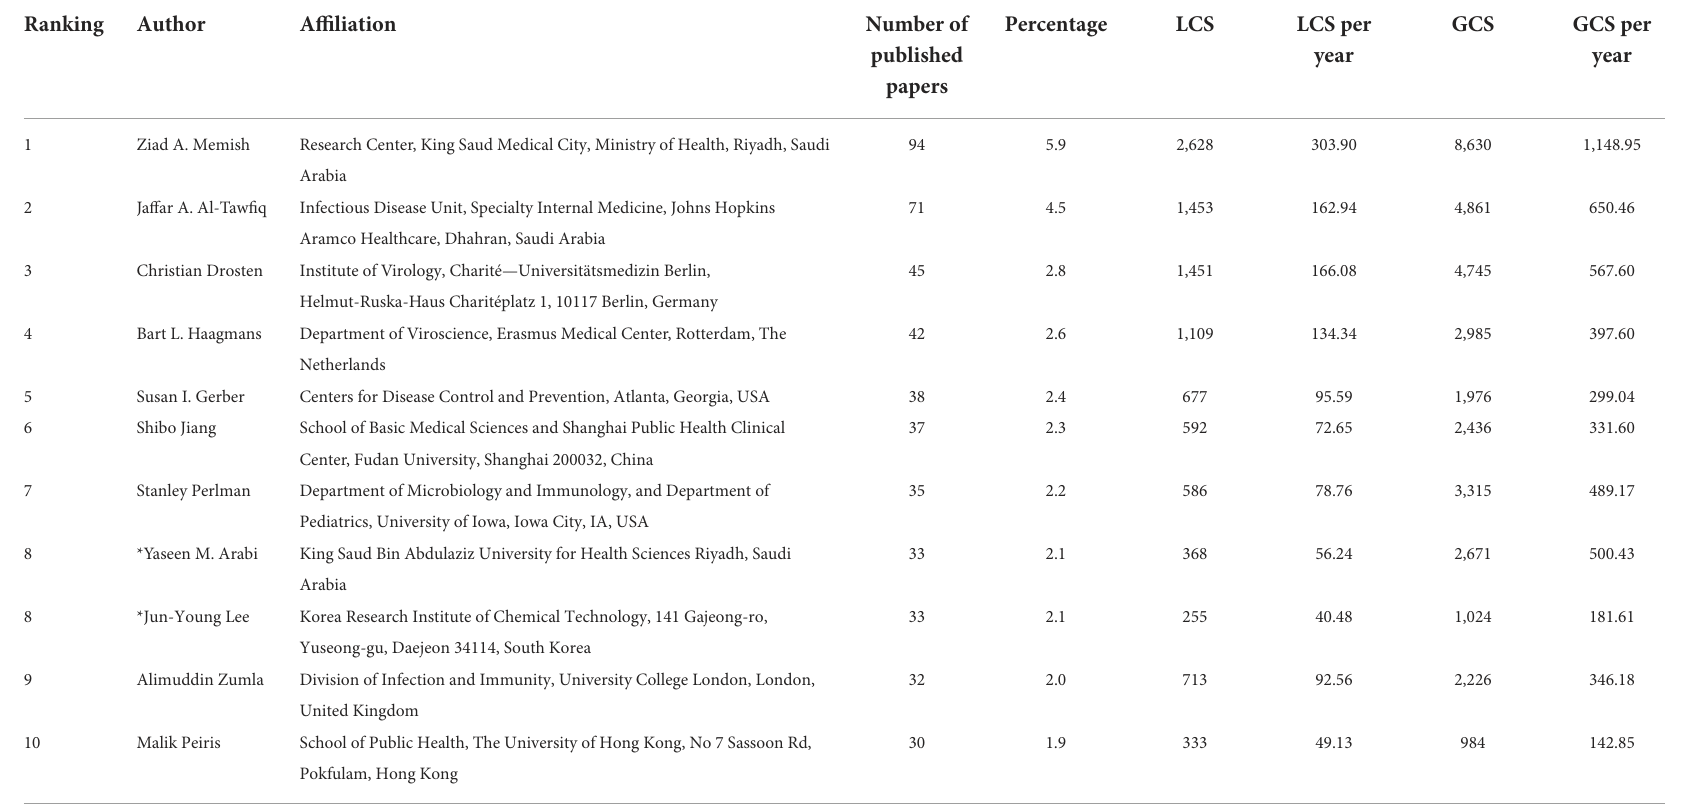
TABLE 5 Top 10 most prolific authors based on number of